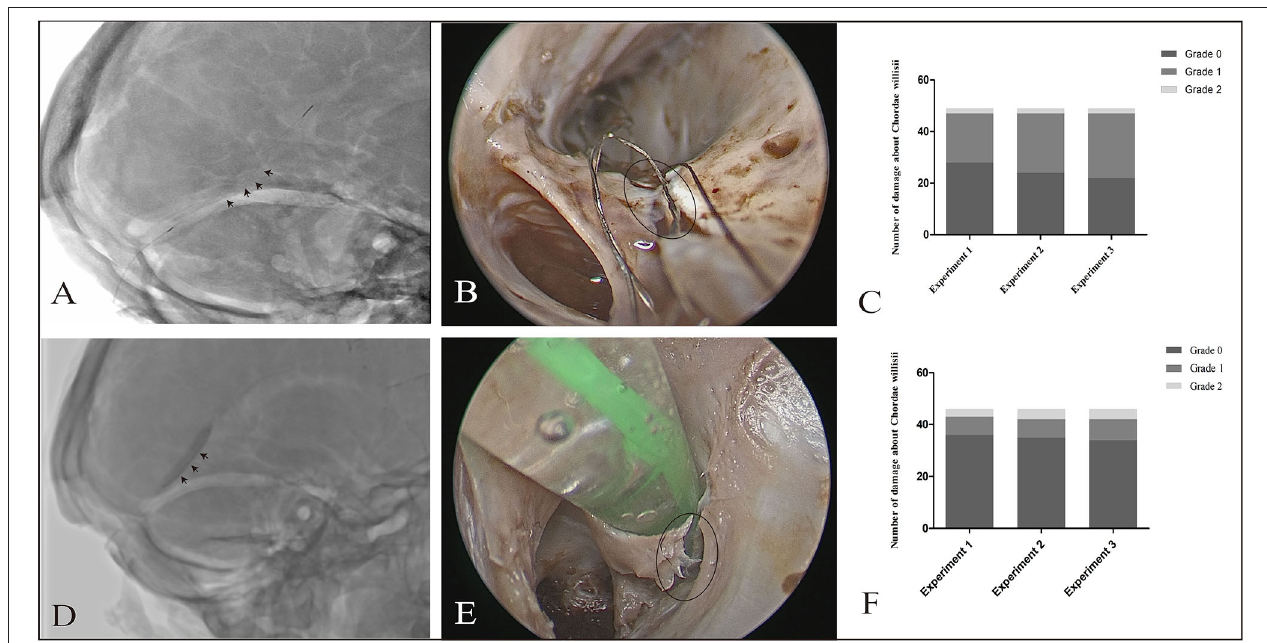
FIGURE 4 | Effect of a stent/balloon on the CW in the SS. The stent was delivered to the anterior third of the SS along a microcatheter (black arrowhead: stent) (A) . Damage of Grade 1 (B) was observed by endoscopic view with 0 ◦ optics (black circle: damage area). Graphs show comparisons of the damage to the CW among three replicates in the stent group (C) . The balloon was delivered to the SS, dilated, and drawn slowly back to the sigmoid sinus (black arrowhead: balloon) (D) . Grade 2 damage was observed by endoscopy (black circle: damage area) (E) . Graphs show comparisons of the damage to the CW among three replicates in stent group (C) and balloon group (F)